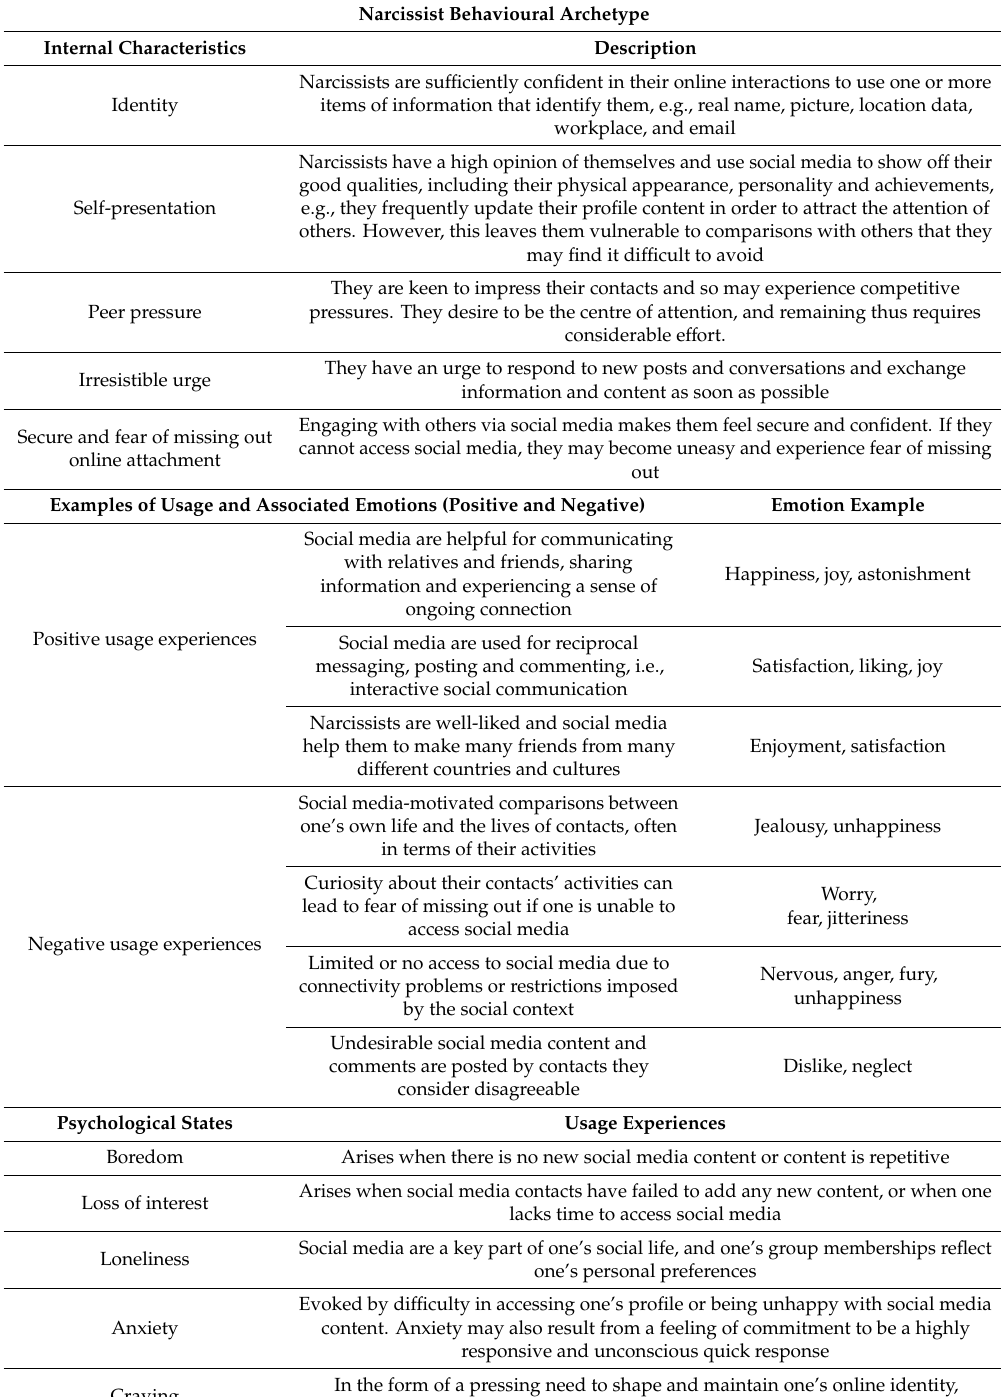
Table 8. Overview of the Narcissist behavioural